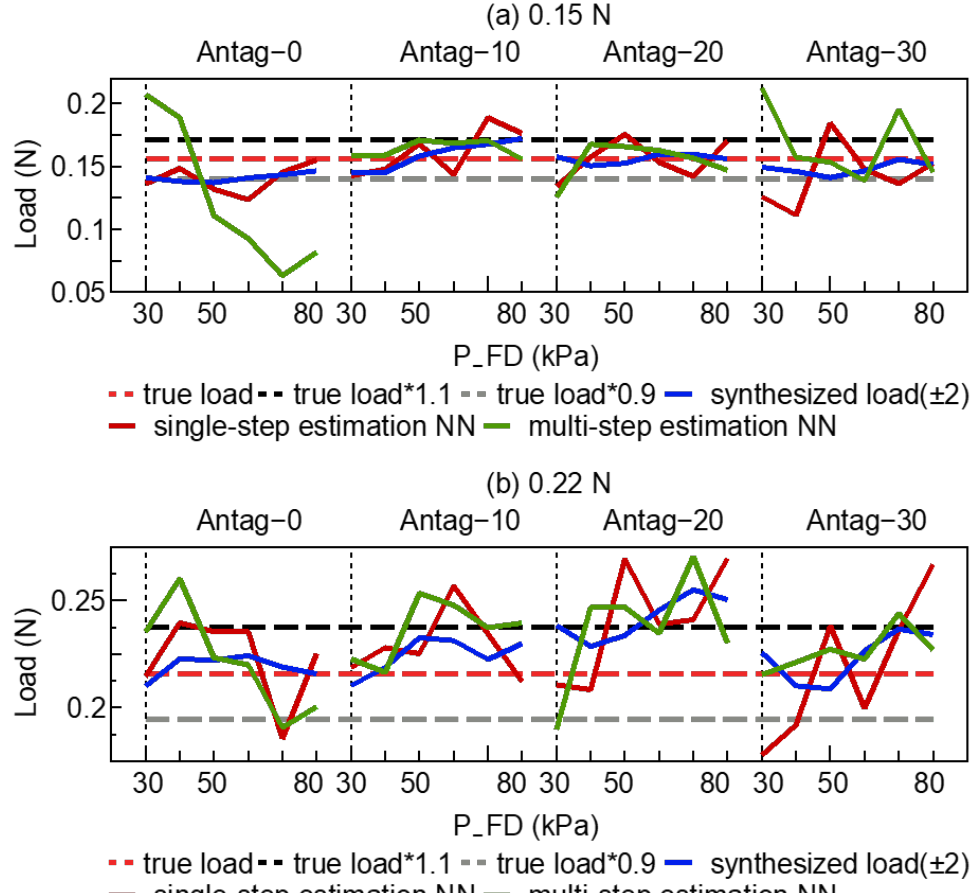
Figure 10. The test data of active load-sensing scheme with 5.0 mm endoscope from NN using sin- gle-step estimation NN and multi-step estimation NN ( a ) 0.15 N, ( b ) 0.22 N. single-step estimation NN and multi-step estimation NN ( a ) 0.15 N, ( b ) 0.22